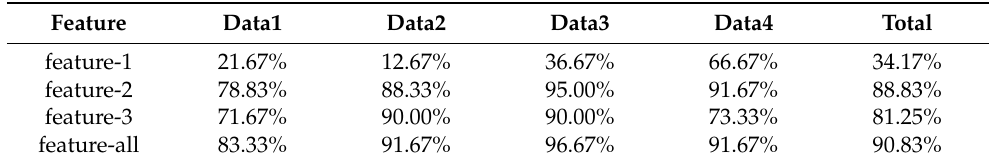
Table 2. The classification results of different